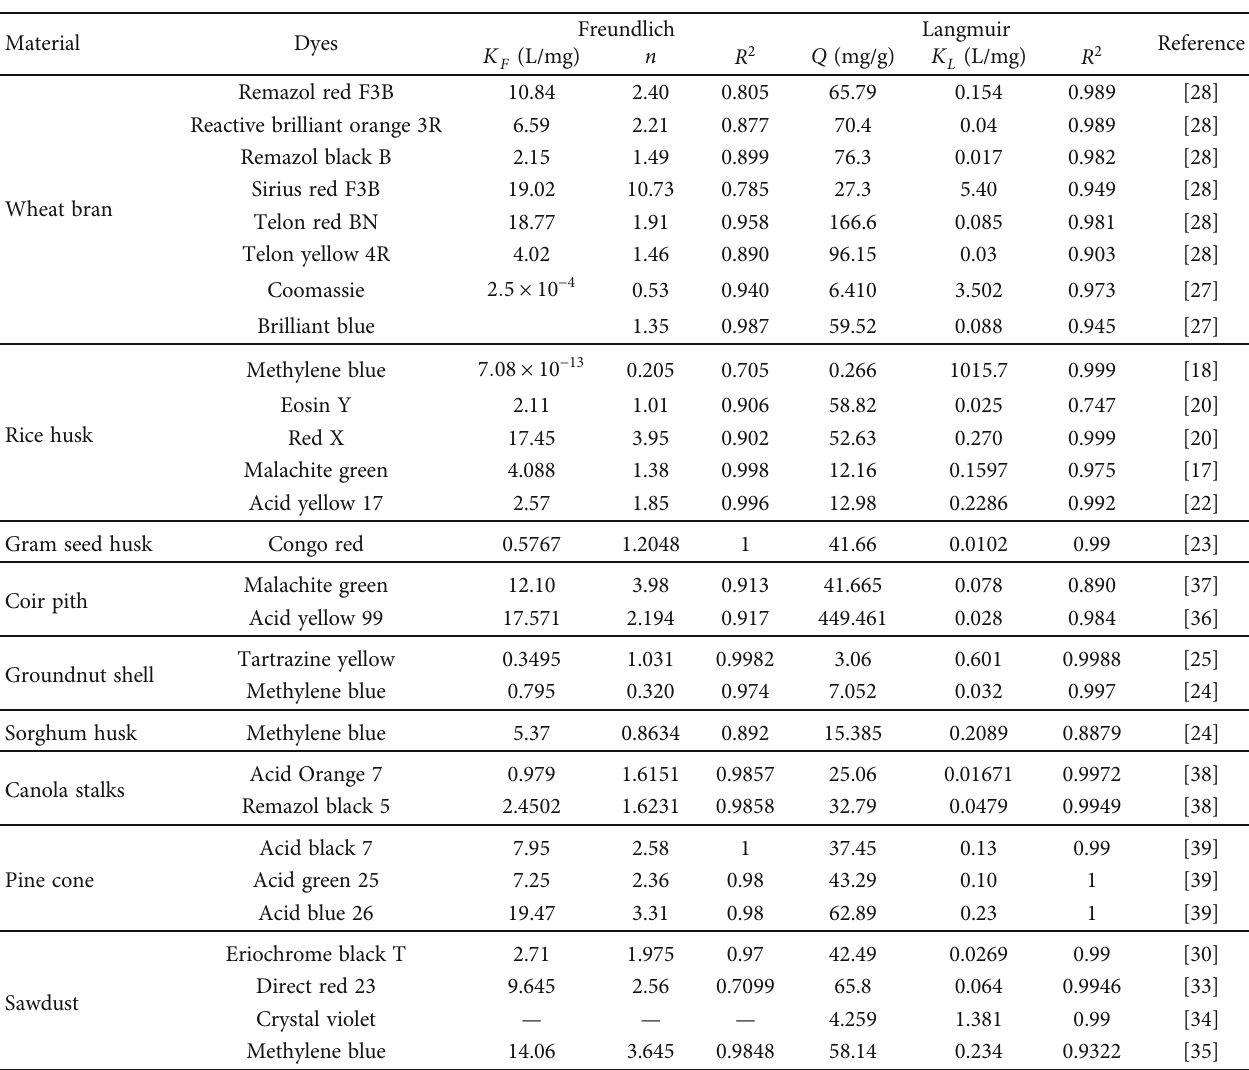
Table 7: Reported parameter values for Freundlich and Langmuir isotherm models for dye adsorption on various biomass-derived